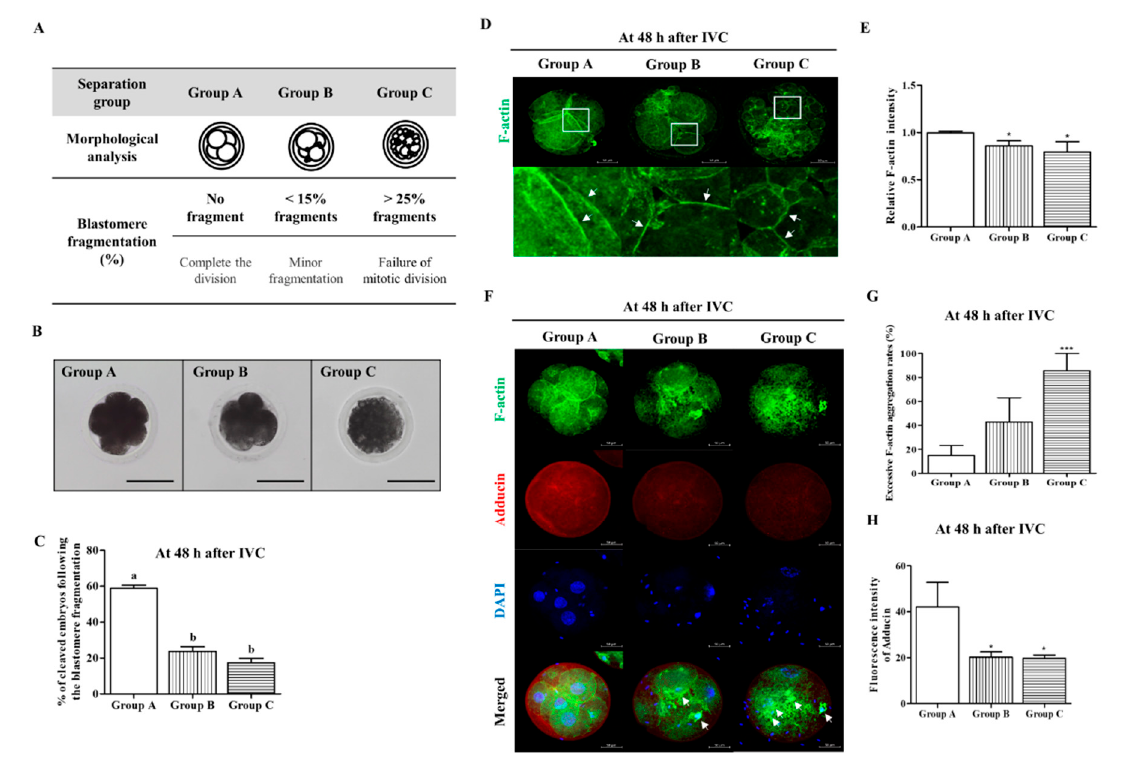
Figure 1. Porcine embryos reduced accumulation of adhesive junction F-actin and adducin expression according to blastomere fragment rate. ( A ) Typical images were divided into three groups (Groups A, B, and C) based on morphological criteria of blastomere in porcine embryos at the cleavage stage. Group A: Equal size blastomeres and completed the division state without fragmentation. Group B: Minor fragmentation state with less than 15%. Group C: Unequal size blastomeres with more than 25% fragments (failure of mitotic division state). Scale bar = 150 µ m. ( B ) Bright-field micrograph of porcine embryos (4- or 8-cell stage) in three groups (Groups A, B, and C) according to the presence or absence of blastomere fragmentation. ( C ) Change in cleavage rate (%) of porcine embryos according to the blastomere fragmentation percentage. The data are expressed as means ± SD. Different superscripts denote a significant difference ( p < 0.05). ( D , E ) In porcine embryos at the cleaved stage, accumulation or intensity of adhesive junction F-actin expression (white arrows) was reduced with increasing blastomere fragment ratio. Scale bar = 50 μ m. ( F – H ) Confirmation of chang- ing F-actin aggregation, co-location of F-actin, and adducin fluorescence expression in Groups A, B, and C embryos. Fluorescence expressions were presented with F-actin (green), adducin (red), and nuclei (blue) using immunofluorescence and 4 ′ ,6-diamidino-2-phenylindole (DAPI) staining. Scale bar = 50 μ m. Data in the bar graph are presented as the mean ± SD of three independent experiments. Differences were considered significant at * p < 0.05 and *** p < 0.001 as compared to the group A. 3.2. Interrelation of Blastomere Fragmentation and Cleaved Embryo Ratio in Paclitaxel Exposed Porcine Embryos Some studies have reported that actin cytoskeleton organization and blastomere morphology are crucial factors that contribute to embryo quality [26]. Thus, we investi- gated the percentage of blastomere fragments based on equal blastomere division and fragment rate in porcine cleaved embryos two days after treatment with 10 or 100 nM paclitaxel. Embryos exposed to 10 nM paclitaxel showed the highest proportion of Group A embryos with 0% blastomere fragmentation (Figure 2B and Table 2). These findings showed similar patterns for cleaved embryo ratio in 10 nM paclitaxel treated embryos belonging to Groups A, B, and C compared with results of non-treated porcine embryos ( p < 0.05; Group A: 57.6 ± 9.9% vs. Group B: 23.6 ± 6.4%, and C: 18.8 ± 8.8%). We next explored whether the application of 100 nM paclitaxel affected the embryonic cleavage